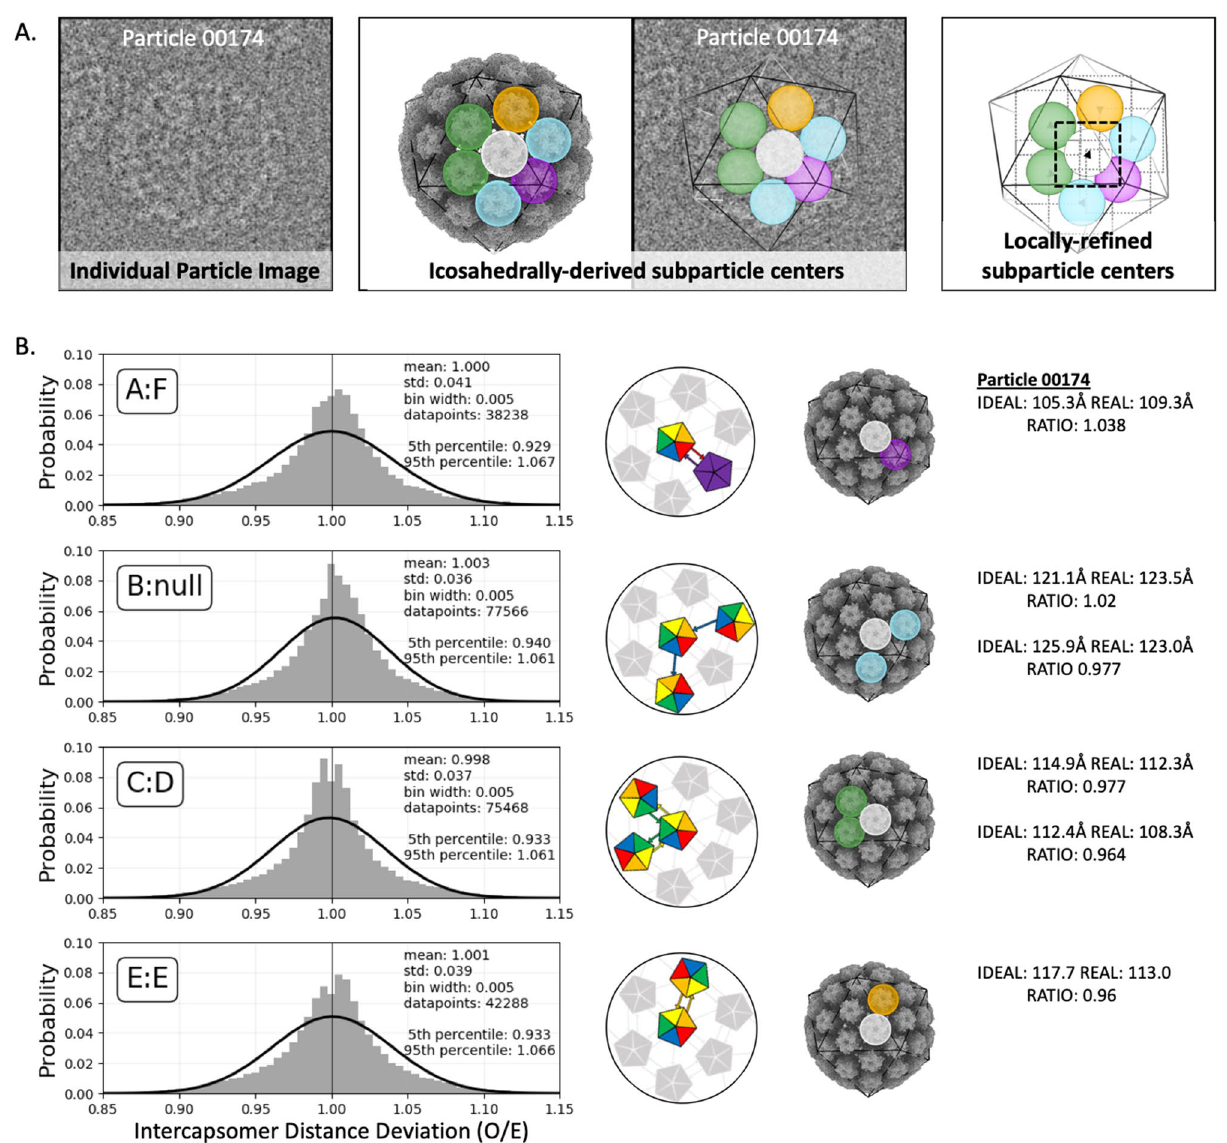
Figure 6. Inter-capsomer distances. ( A , left) An example of a particle oriented in one of the cryo EM micrographs so that it met the selection criteria (Methods) for capsomer distance analysis. ( A , center) The same particle also illustrated in a 3D surface rendered model (gray) and outlined with icosahedral cage (black line) with a reference capsomer (white sphere) indicated centrally in the hexavalent capsomer. Relative to the reference, there are four different arm configurations: the hexavalent-pentavalent axis (A:F arm exchange) (purple); the fivefold-adjacent hexavalent-hexavalent axis (unidirectional B arm contribution) (blue); the threefold-adjacent hexavalent-hexavalent axis (C:D exchange) (green); and the twofold hexavalent-hexavalent axis (E:E exchange) (orange). The particle origin and orientation found during icosahedral refinement determined the idealized capsomer locations. ( A , right) Local subparticle refinement found the correct capsomer centers (black arrowhead), which then can be used to determine the deviation from the icosahedrally- derived, idealized parameters. ( B ) Deviation of inter-capsomer distances from idealized values were plotted and the ratios corresponded to contraction (values < 1) or expansion (> 1). The four unique axes of arm configurations as defined above were plotted. Each axis shows a similar, non-Gaussian pattern of deviation (Gaussian fit, black curve) with a standard deviation of ~ 4%. Values and schematic for the example particle are shown at